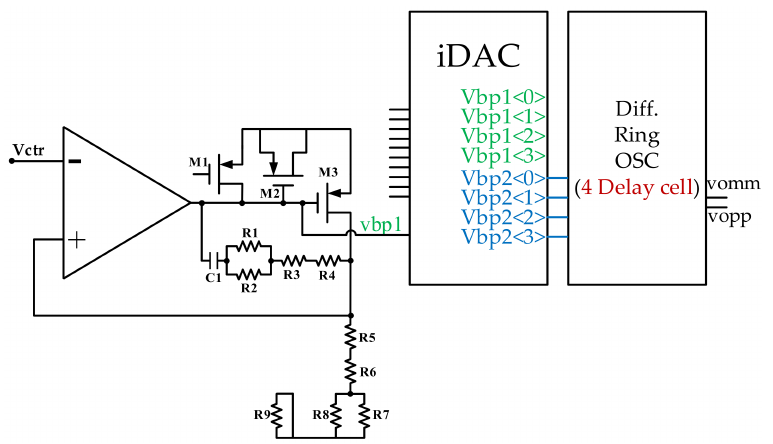
Figure 6. VCO circuit